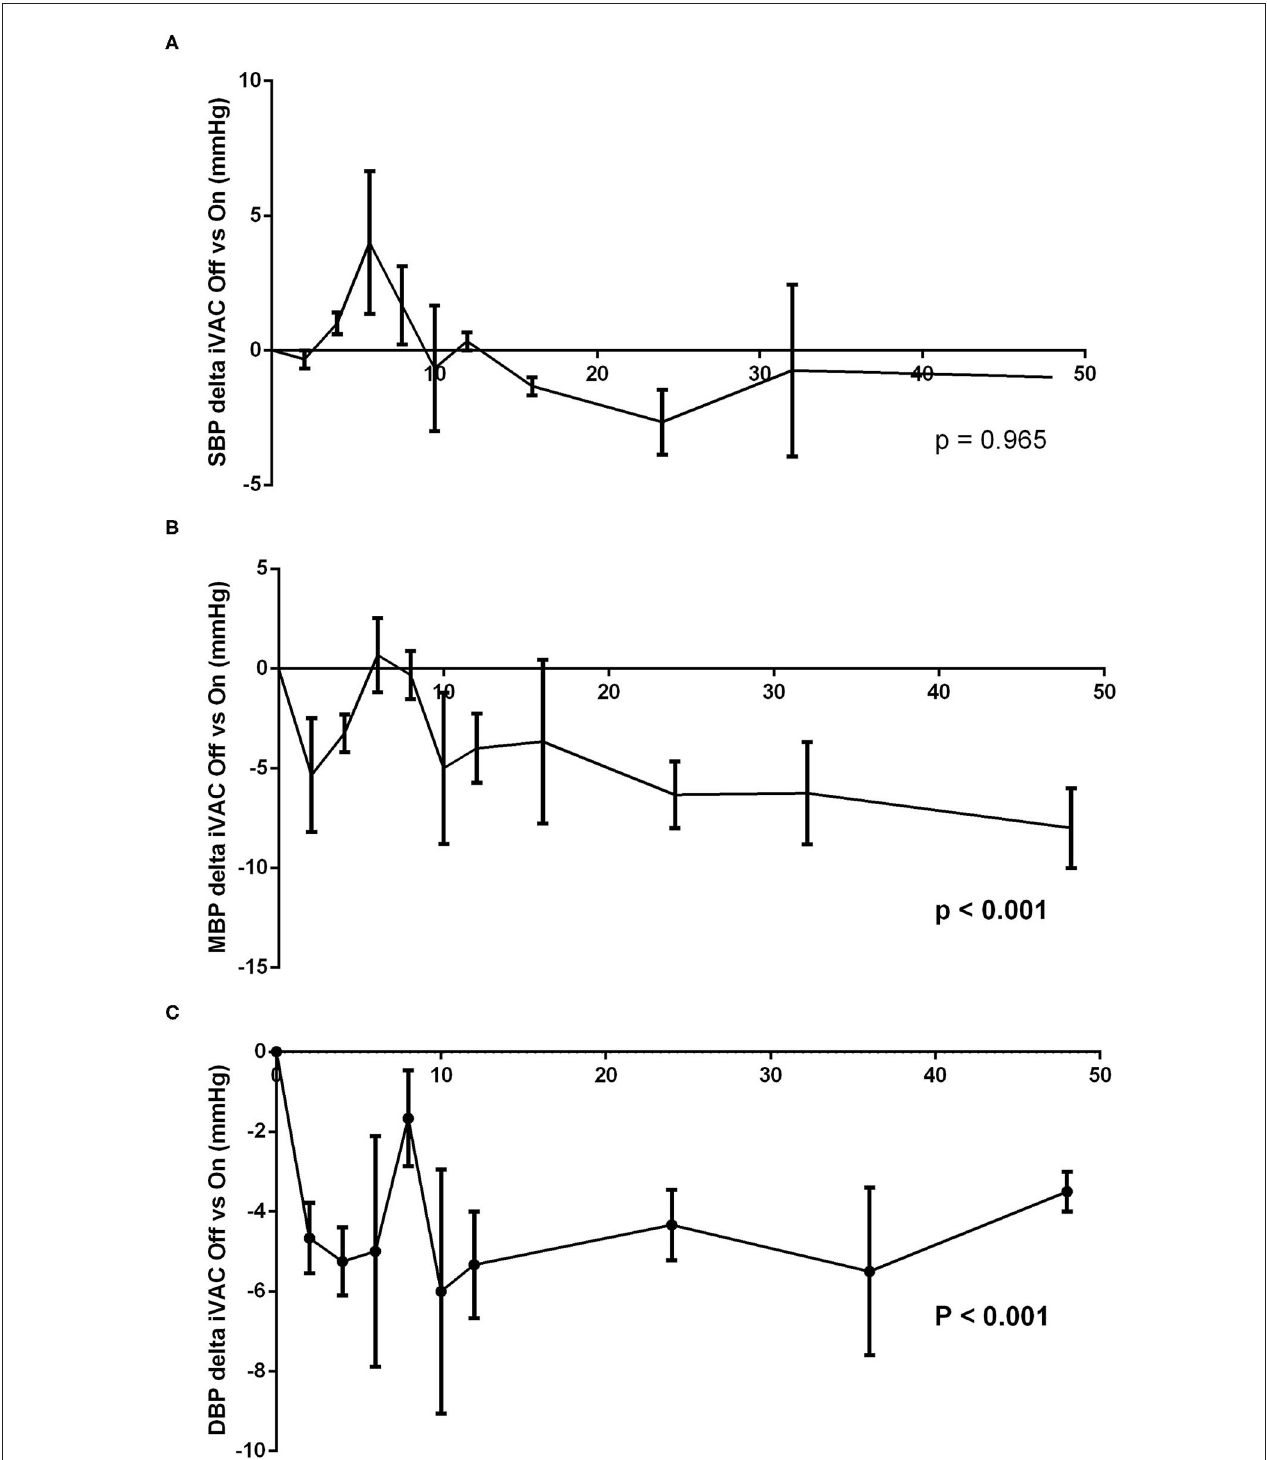
FIGURE 2 | Analysis of difference between systolic blood pressure (SBP) (A) , mean blood pressure (MBP) (B) , and diastolic blood pressure (DBP) (C) with and without IVAC2L support in healthy pigs. At different times (H0, H2, H4, H6, H8, H10, H12, H16, H24, H36, and H48), the IVAC2L support was deactivated by turning Off the extra-corporal pump during 5min and then, reactivated until next time point. Invasive and non-invasive hemodynamic parameters were recorded throughout the procedure and until 48h. Data are presented at each time points by the delta pressure mean between IVAC2L On and Off ± SEM ( n = 6). The values of p were obtained by comparing the delta pressure On and Off for each parameter. DBP, diastolic blood pressure; MBP, mean blood pressure; SBP, systolic blood pressure; SEM, standard error of mean.